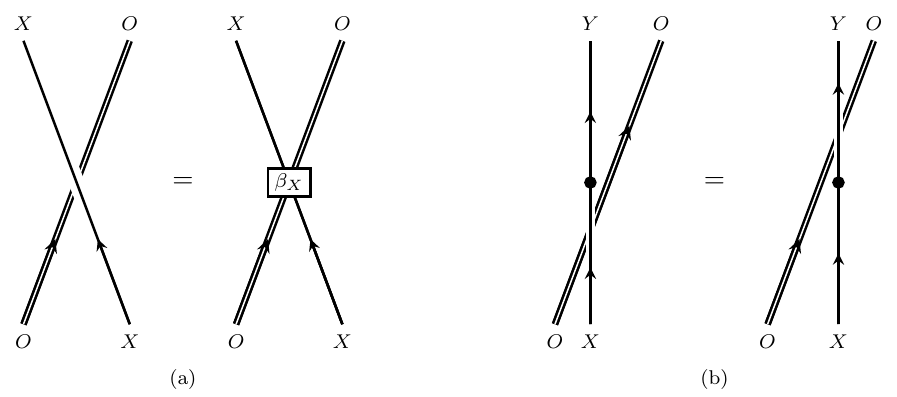
Figure 12 . Bulk lines and Drinfeld Center: (a) Bringing a bulk line O to the boundary such that its image crosses a boundary line X gives rise to a canonical half-braiding given by morphism (cid:12) X . (b) Bringing O to the boundary in two di(cid:11)erent ways as shown in the (cid:12)gure is equivalent and hence (cid:12) commutes with other morphisms.